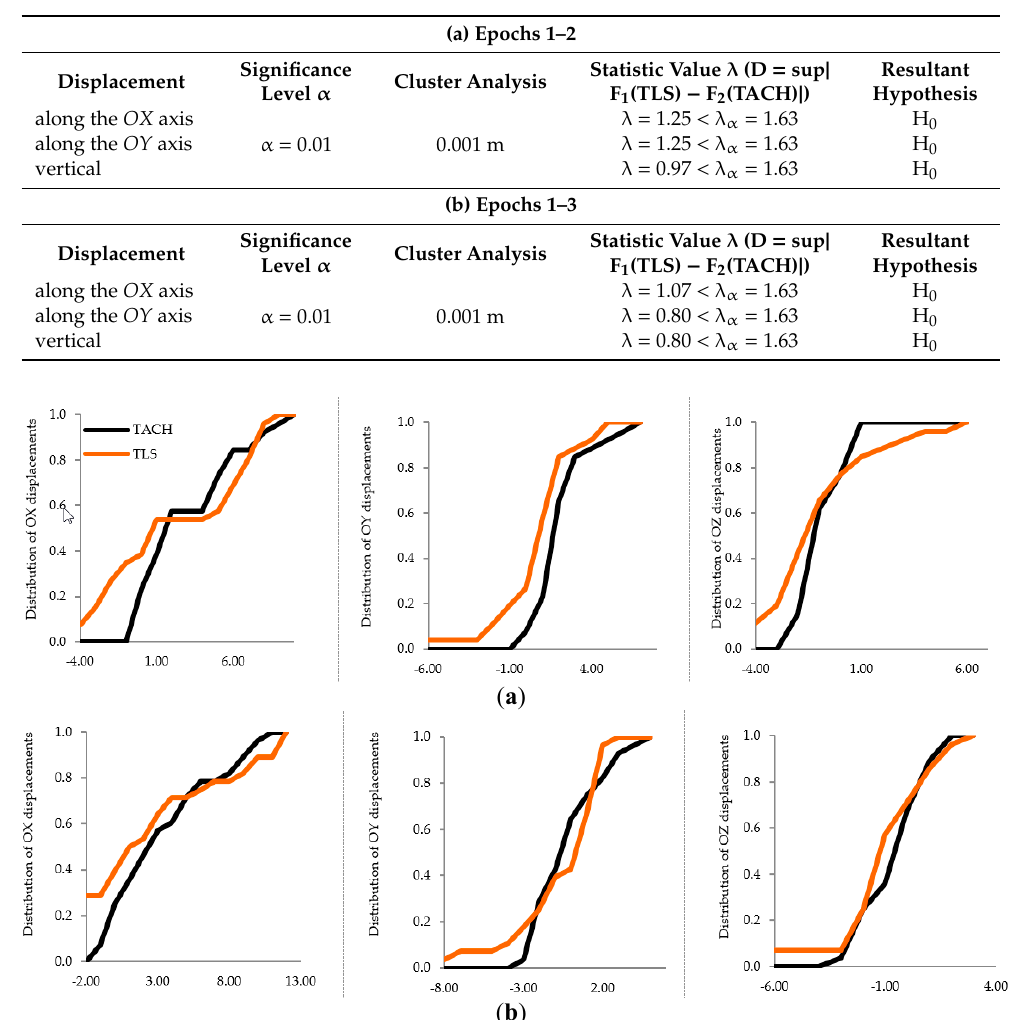
Figure 4. Distribution of spatial displacements TLS vs, TACH; OX axis: Clusters, OY axis: Distribution of displacements; ( a ) Epochs 1–2, ( b ) Epochs 1–3.